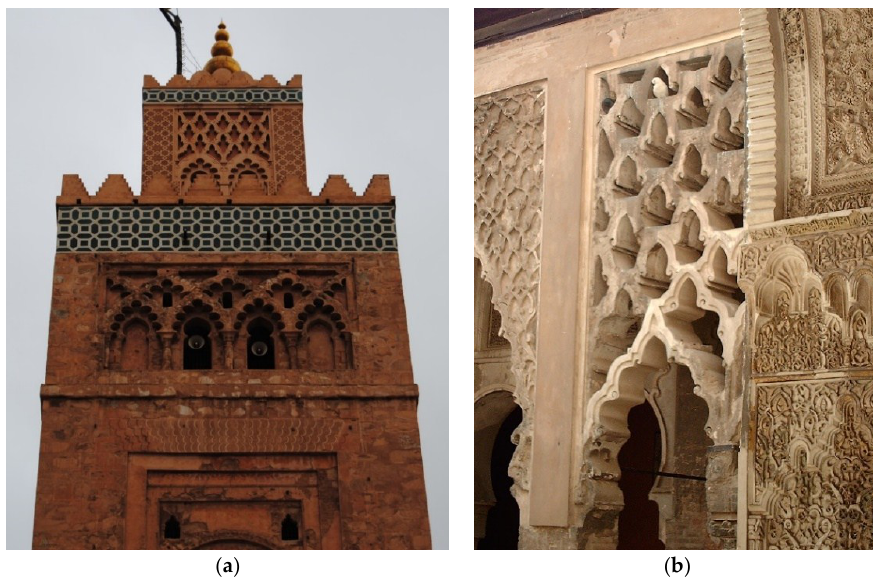
Figure 5. Finishing of the first body of the minaret of the Kutubiyya mosque ( a ). Photo took by author. Detail of the southern portico of the Patio del Yeso, Reales Alcázares (Seville) ( b ). Photo took by author.